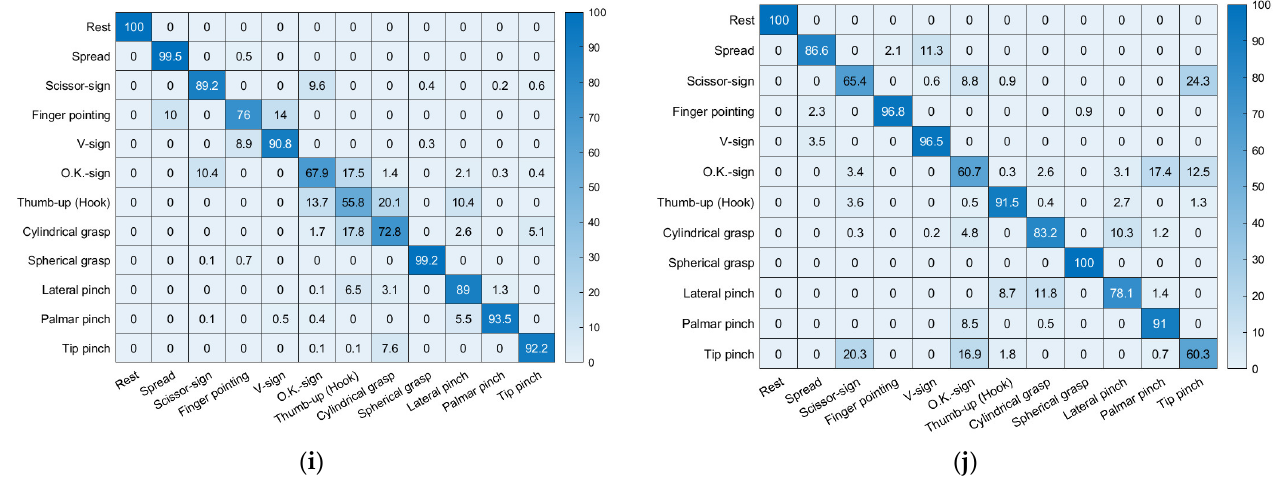
Figure 11. Confusion matrixes for the forearm amputee: ( a – e ) Day 1 to Day 5 with MAV only, ( f – j ) Day 1 to Day 5 with Hudgins’ set.